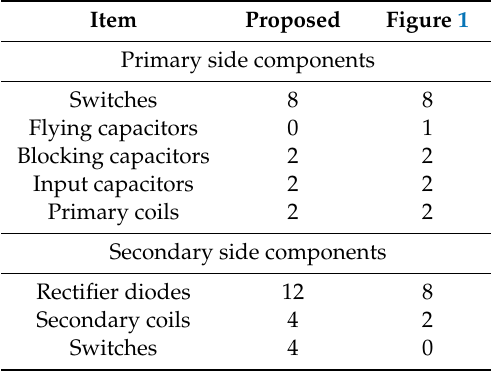
Table 7. Components comparison.